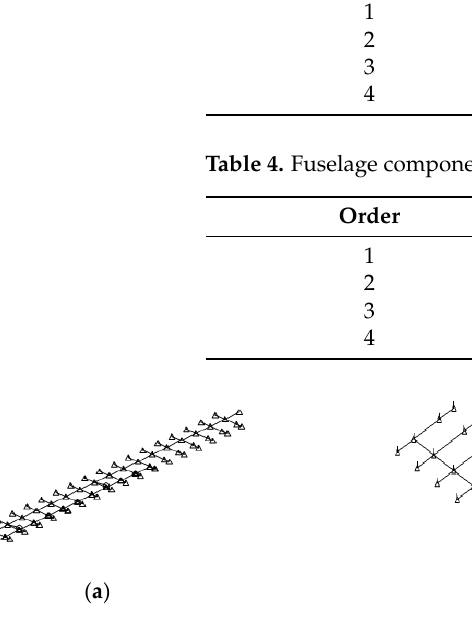
Figure 4. Substructure model of left wing component, fuselage component and right wing component. ( a ) left wing component. ( b ) fuselage component. ( c ) right wing component.